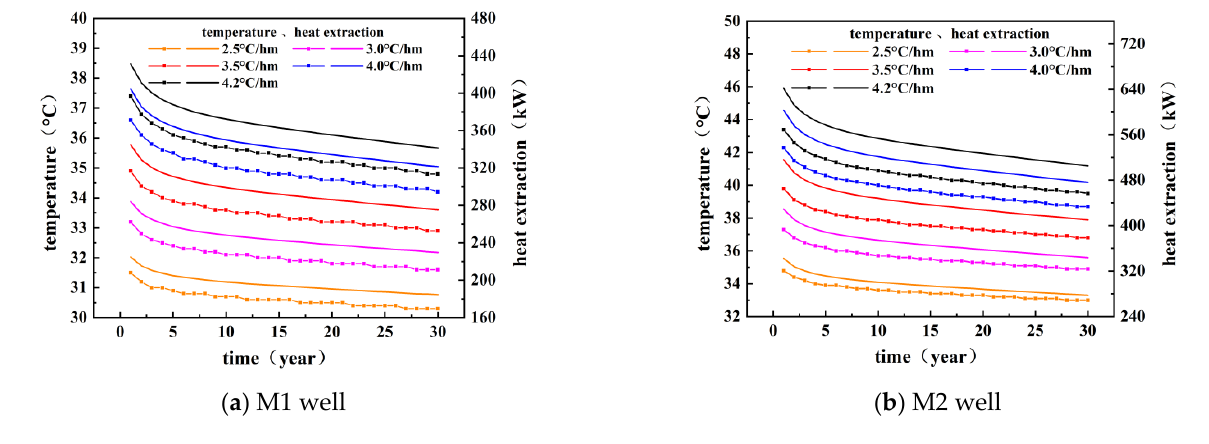
Figure 5. Comparison of production temperature and heat extraction under different geothermal gradients.